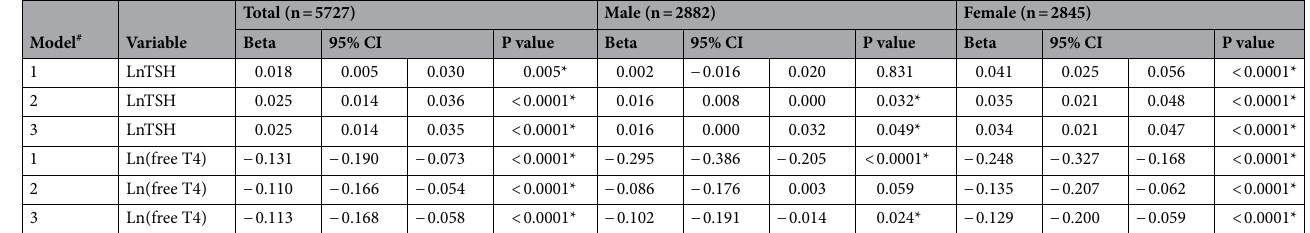
Table 2. Association between thyroid function and TyG index. # Model 1: linear regression analysis, 2: multiple regression analysis after adjustment for age, sex, systolic blood pressure, BMI, alcohol consumption, 3: multiple regression analysis after adjustment for age, sex, systolic blood pressure, waist circumference, alcohol consumption * P -values < 0.05 were considered as statistically